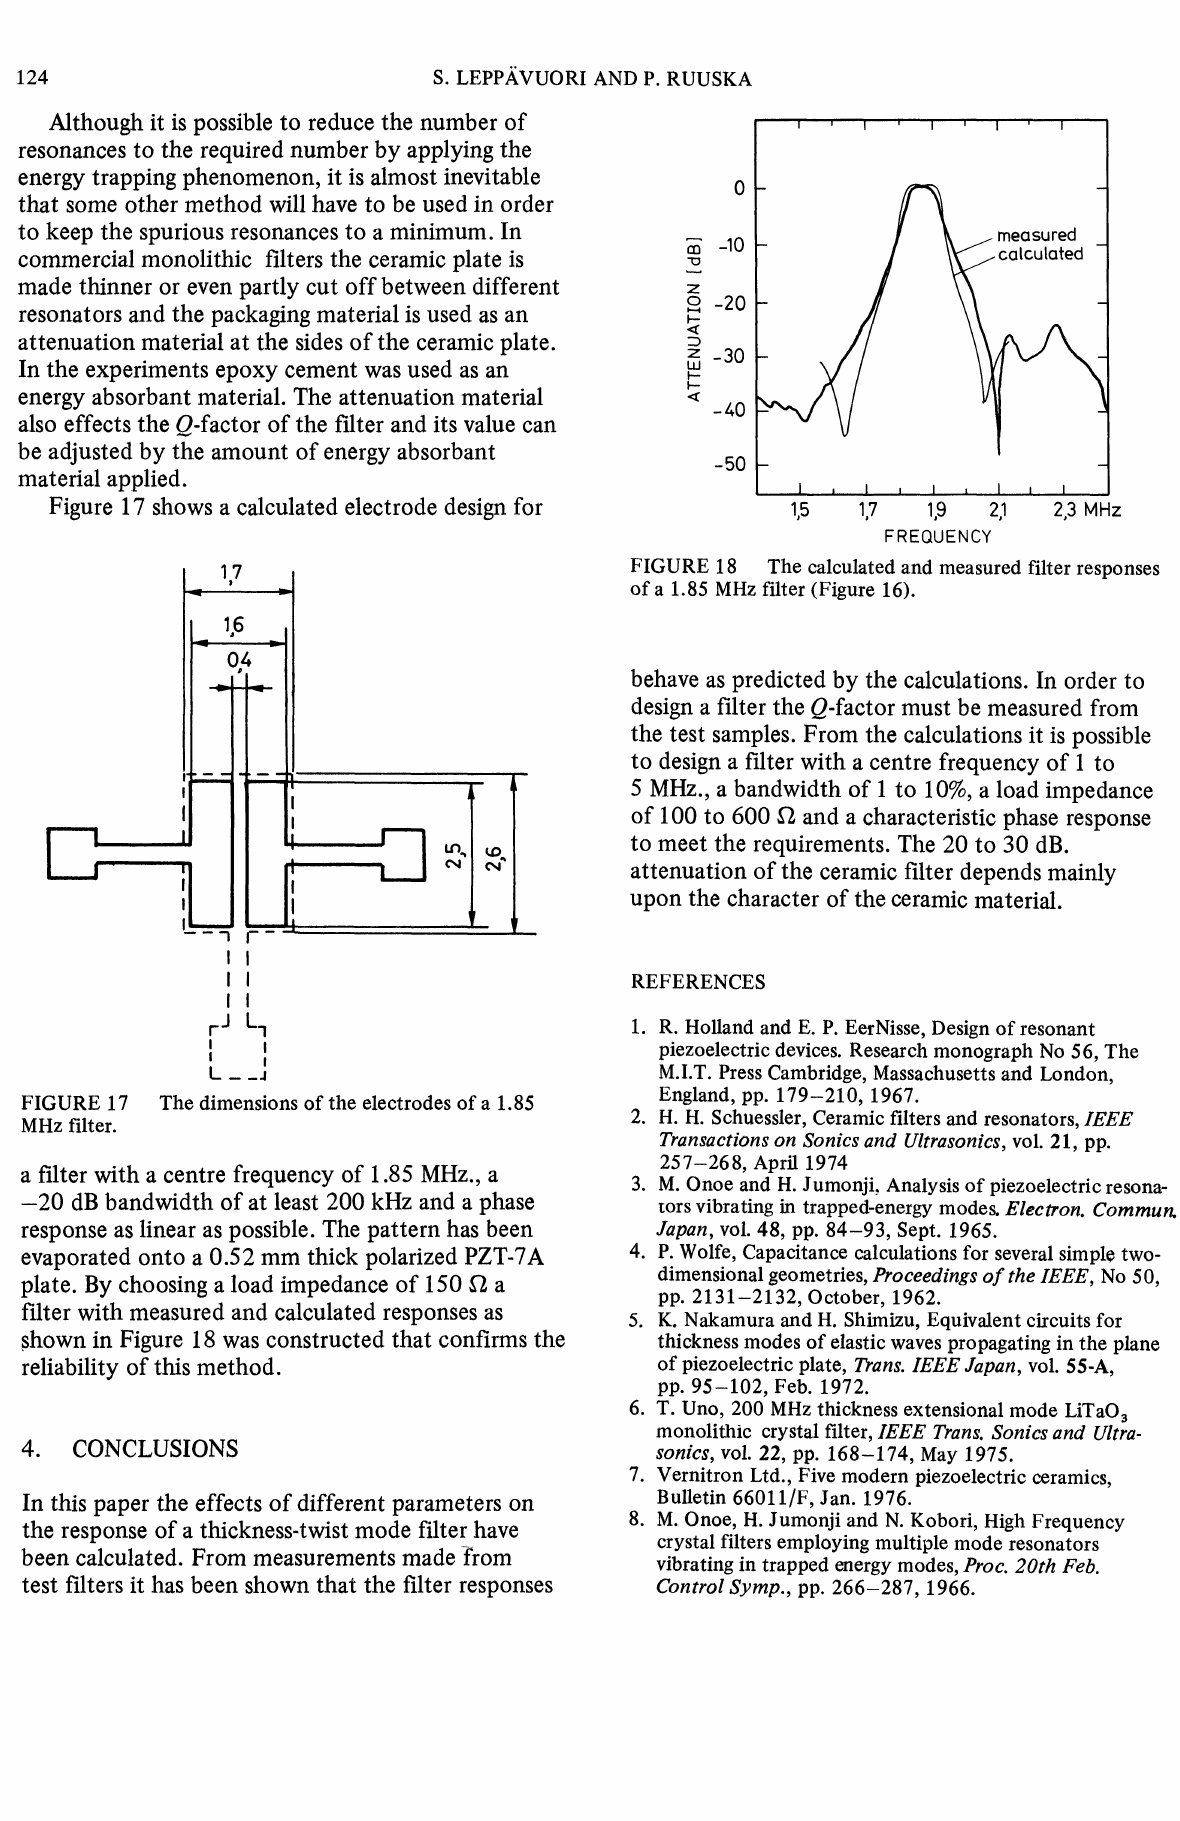
The calculated and measured filter responses of a 1.85 MHz filter (Figure 16).